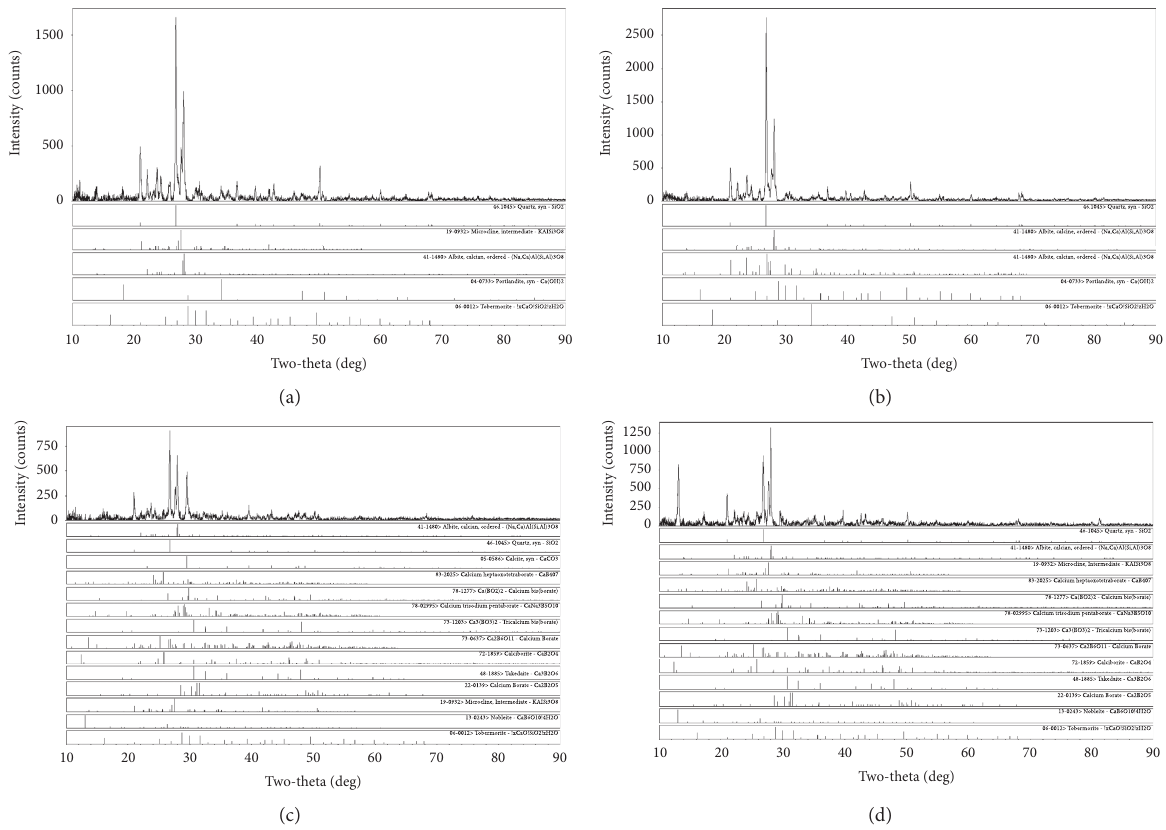
Figure 9: XRD analysis at 300 days of corrosion: (a) immersion 0.8% (2cm), (b) immersion 3% (2cm), (c) dry-wet 0.8% (0cm), and (d) dry- wet 3% (0cm).